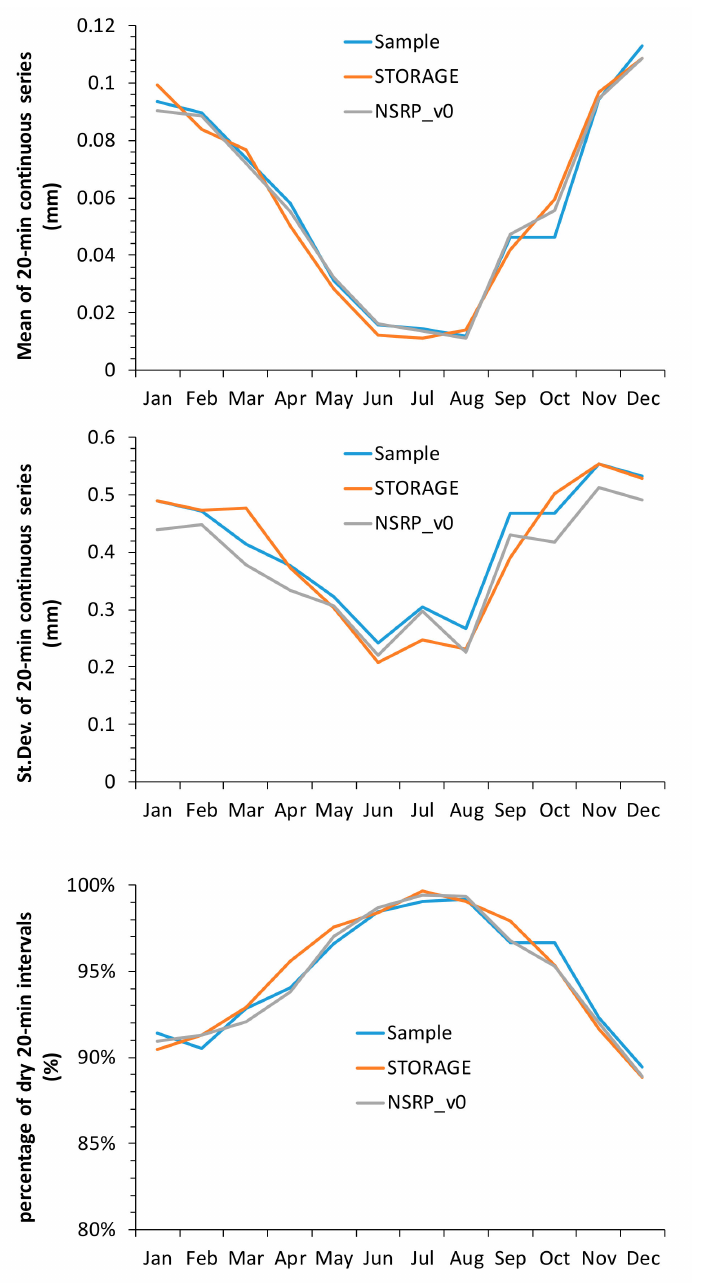
Figure 23. Montalto Uffugo rain gauge: comparison between STORAGE and NSRP_v0 perfor- mances, focusing on the mean, standard deviation and percentage of dry intervals for the continuous 20-min